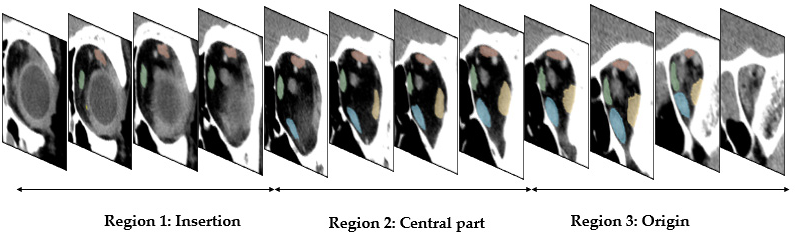
Figure 6. Illustration that shows the coronal slices containing extraocular muscles being split equally into three regions that include the muscle insertion, central part, and origin,